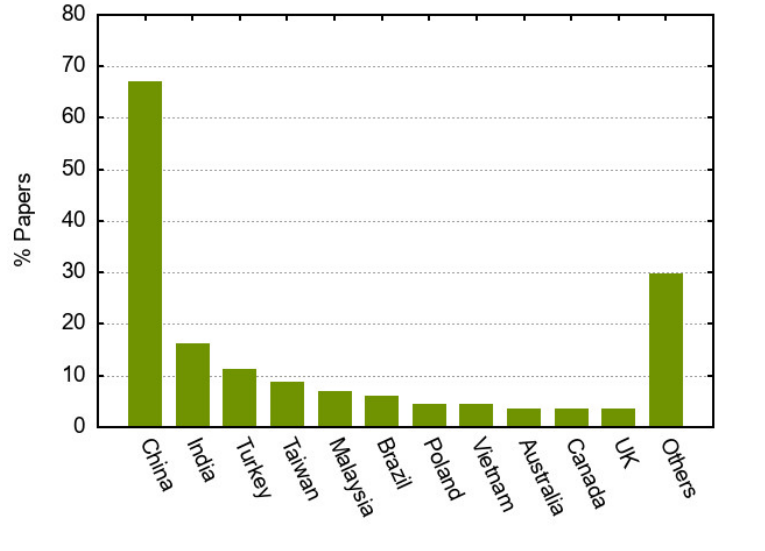
Figure 5. Distribution of papers at country